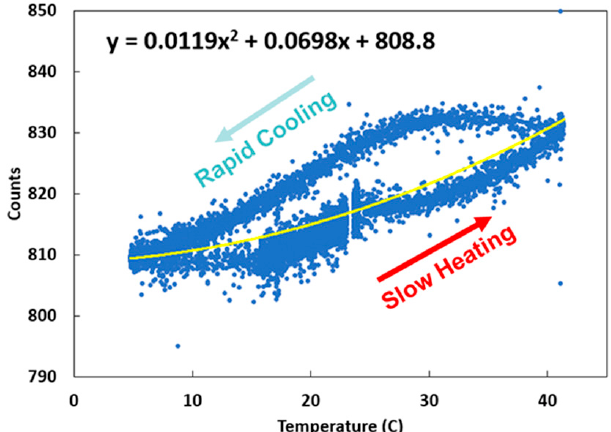
Figure 5. The two spectrometers onboard the instrument were tested and corrected for their temperature dependence of the dark counts ( y -axis). The hysteresis curve is a result of the temperature measurements and the spectrometer counts not changing at the same rate. A second-degree polynomial fit was taken from the resulting curve, and equations for modeling the dark counts of the spectrometer with respect to temperature were derived. This is done to provide the dark counts while the instrument is flying.